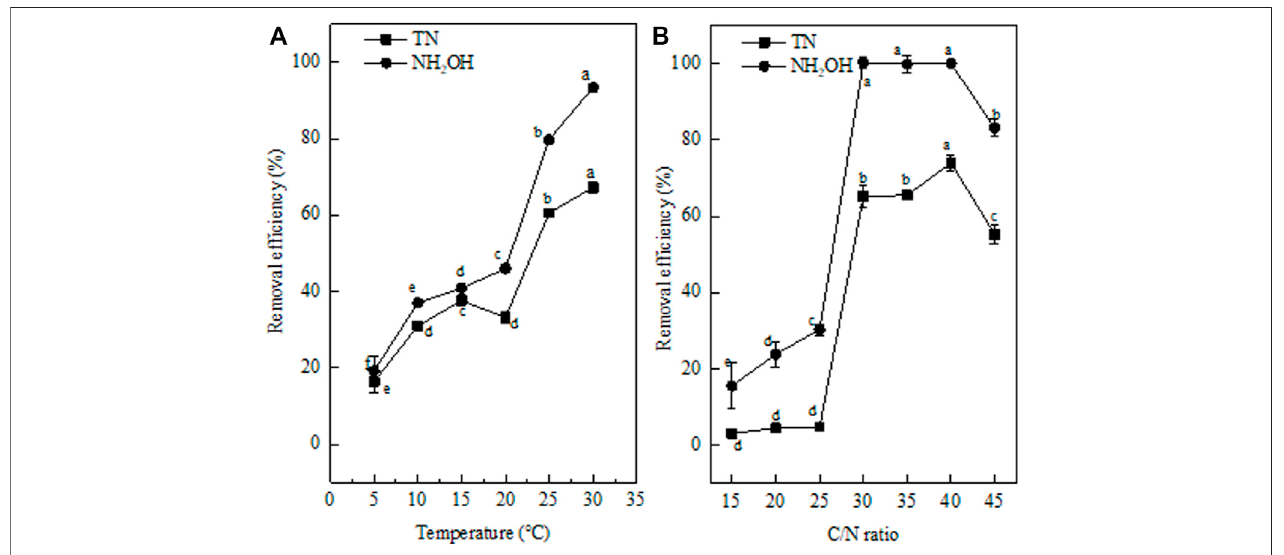
FIGURE 5 | Effect of factors on hydroxylamine removal ability of strain EM-A1. Temperature (A) , C/N ratio (B) . Values are presented as the means ± SD of the results of three replicates (error bars). Different letters indicate signi fi cant differences between treatments at p < 0.05.